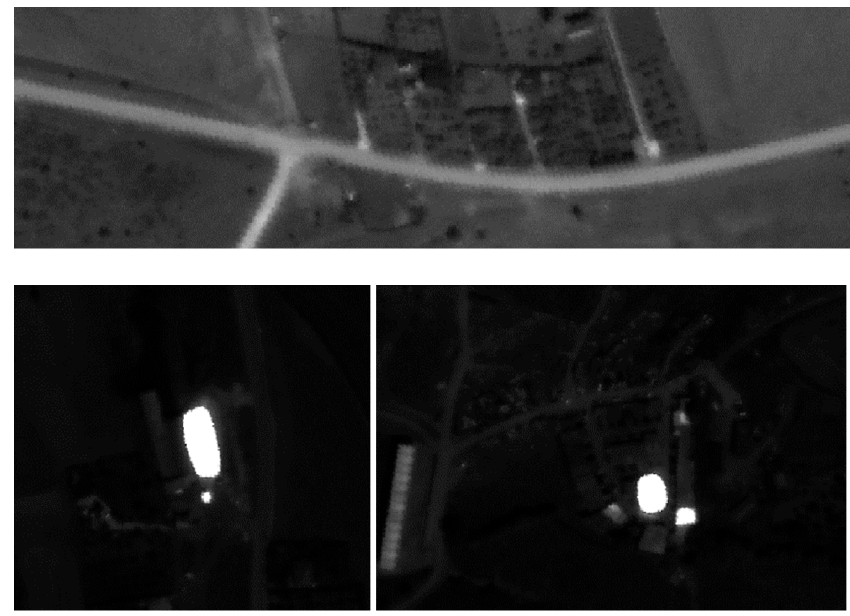
Remote Sens. 2022 , 14 , 1646 Figure 13. Examples of edge jitter ( above ) and saturation ( below ) artefacts in SkySat data.